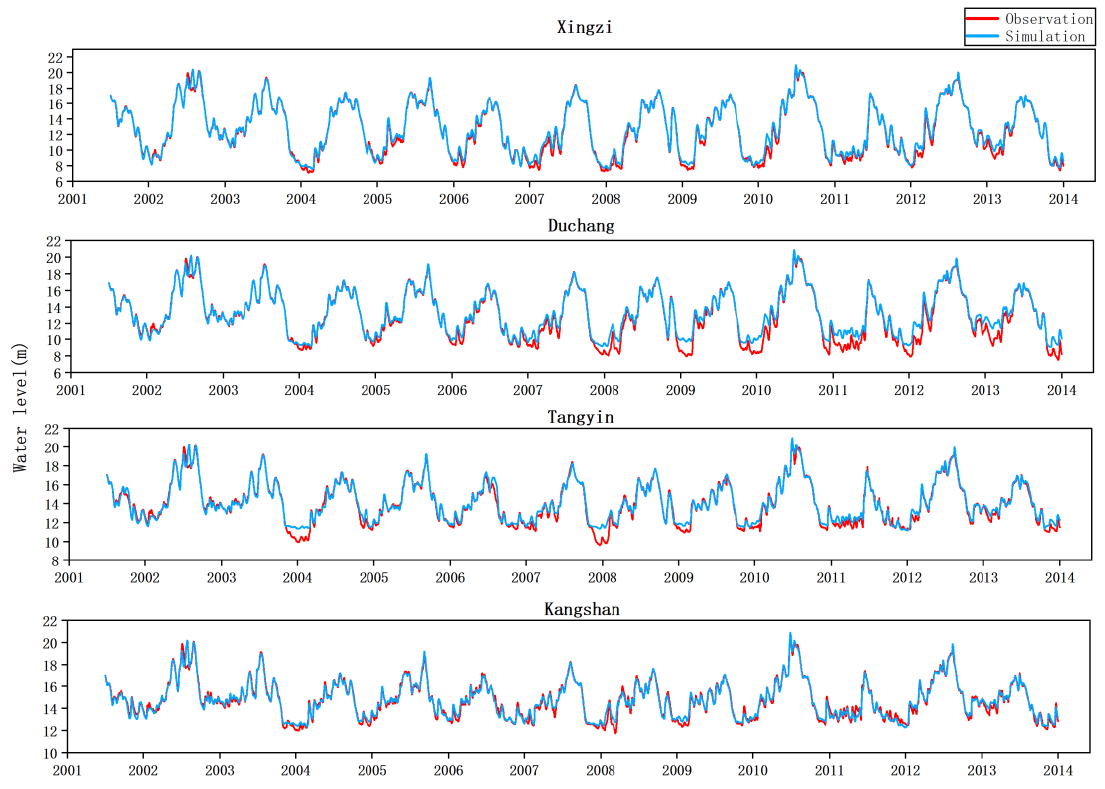
process and the extreme value well. Therefore, it can be considered that the constructed model with S2 can simulate the water level variation process of Poyang Lake basin well.